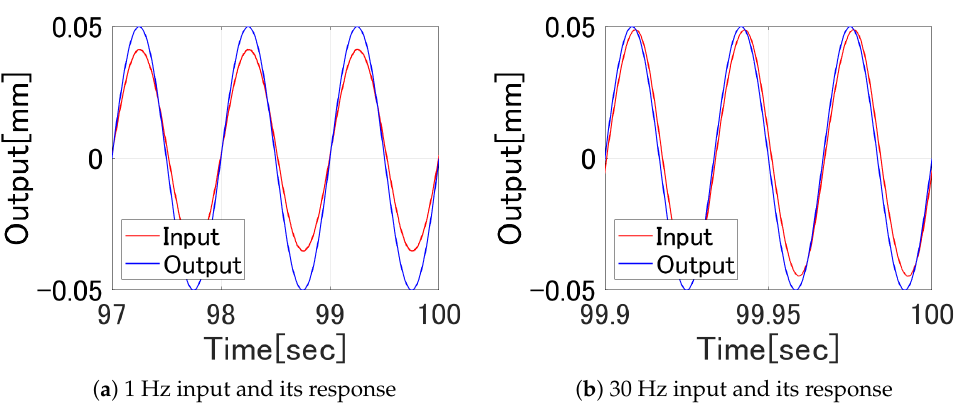
Figure 5. Time domain responses of the actuator for 1 and 30 Hz sinusoidal driving